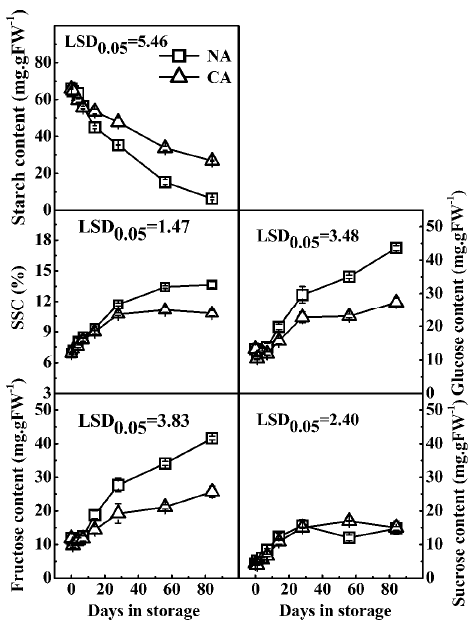
Figure 5. Effect of controlled atmosphere storage (CA, 5% CO 2 + 2% O 2 ) on starch, SSC, and soluble sugars in “Hayward” kiwifruit at 0 °C. NA, normal atmosphere in cold storage (0 °C). FW, fresh weight. Error bars represent ±SE from three replicates. LSDs represent least significant difference at p = 0.05.